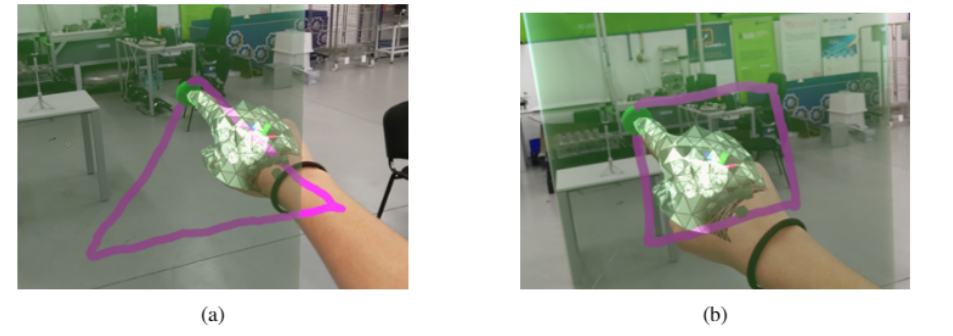
Figure 4. Example of recorded paths: ( a ) triangle. ( b )